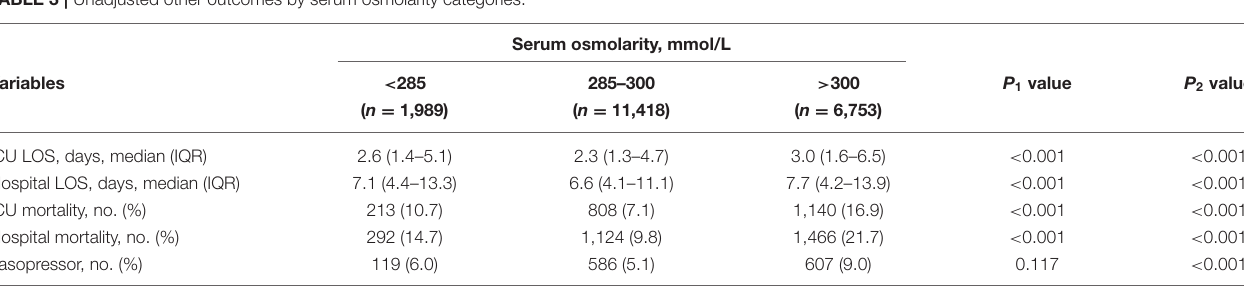
TABLE 3 | Unadjusted other outcomes by serum osmolarity